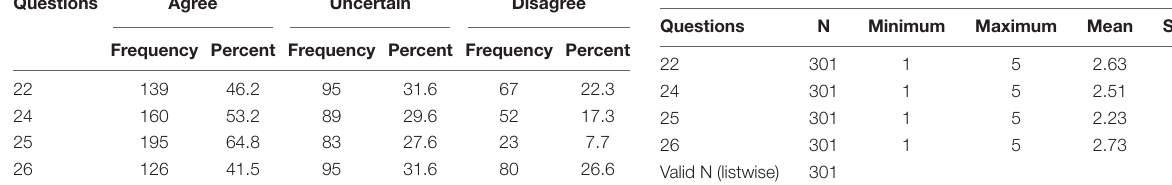
TABLE 15 | Descriptive statistics of the questions related to the learners’ technology literacy in technology-integrated